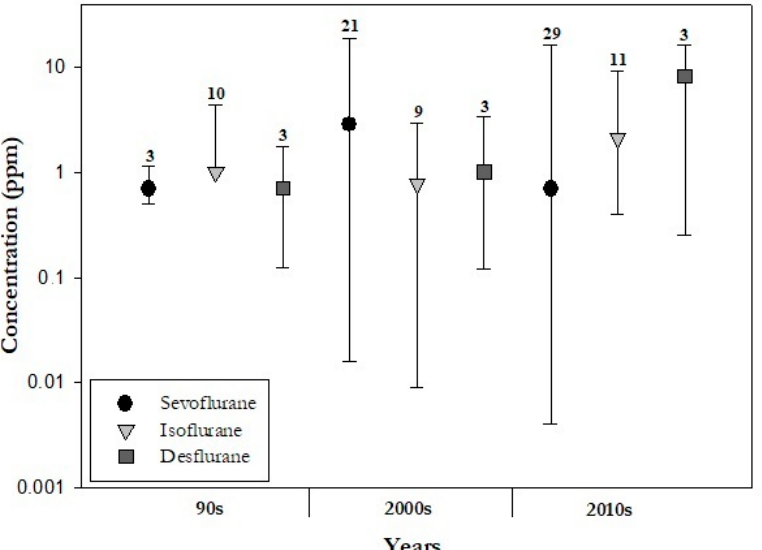
Figure 3. Median (circle, triangle and square), maximum and minimum (error bars) values of sevoflurane, isoflurane and desflurane concentrations in the 1990s, 2000s, 2010s, and number of studies considered per anaesthetic gas.